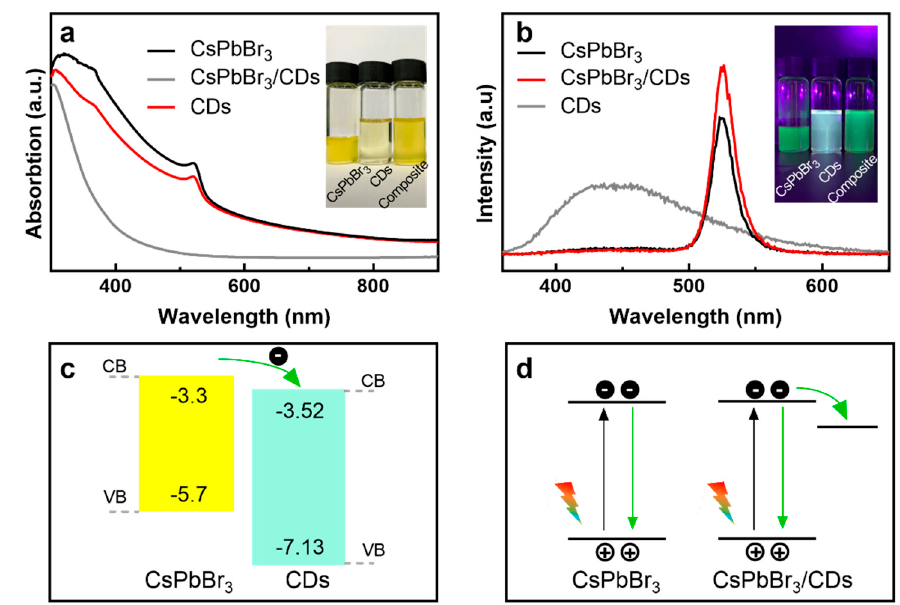
Figure 4. Absorption spectra of CsPbBr 3 and CsPbBr 3 / CD film ( a ), photoluminescence spectra of the carbon nanodots, CsPbBr 3 , and CsPbBr 3 / CD composite ( b ), energy-band structures of perovskite (yellow) and CDs (cyan) with green arrow representing electron transfer from conduction band of the perovskite into the conduction band of the CDs ( c ), and hypothesized recombination mechanisms in pure CsPbBr 3 and CsPbBr 3 / CD composite ( d ). Insets in panels ( a ) and ( b ) show the colors of the solutions under white and UV light,